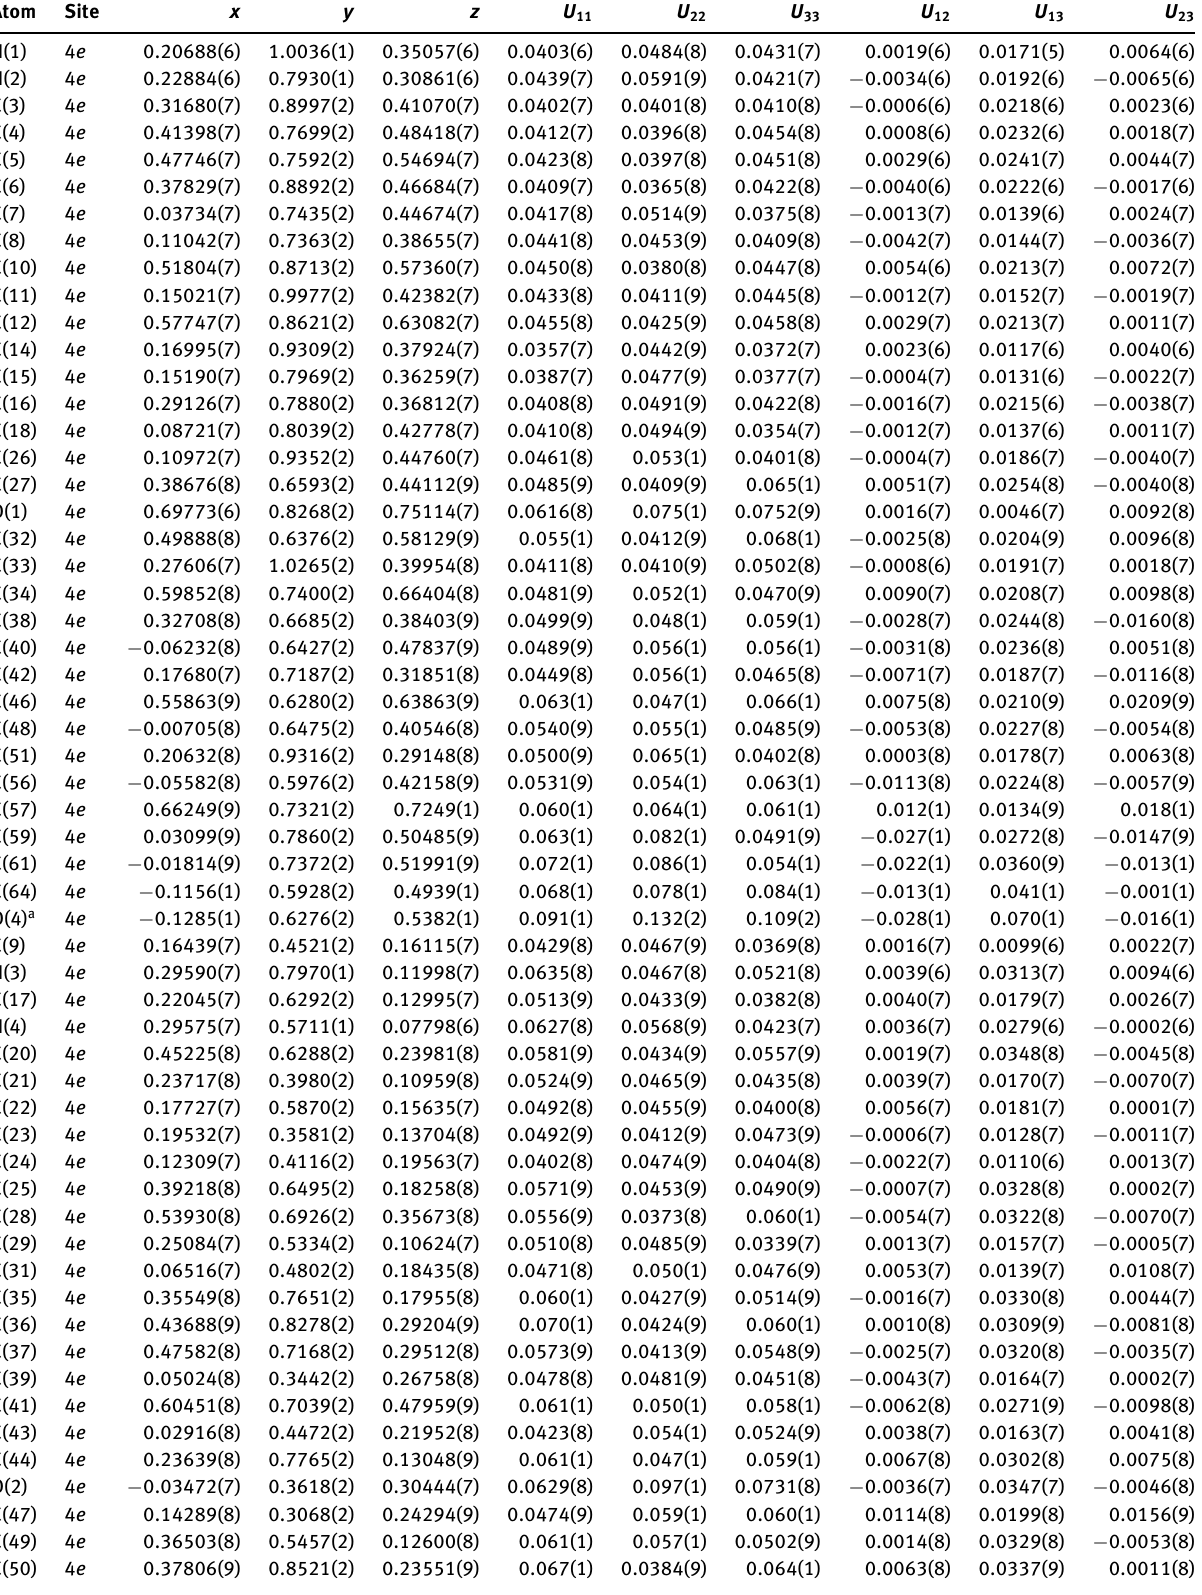
Table 3: Atomic displacement parameters (Å 2